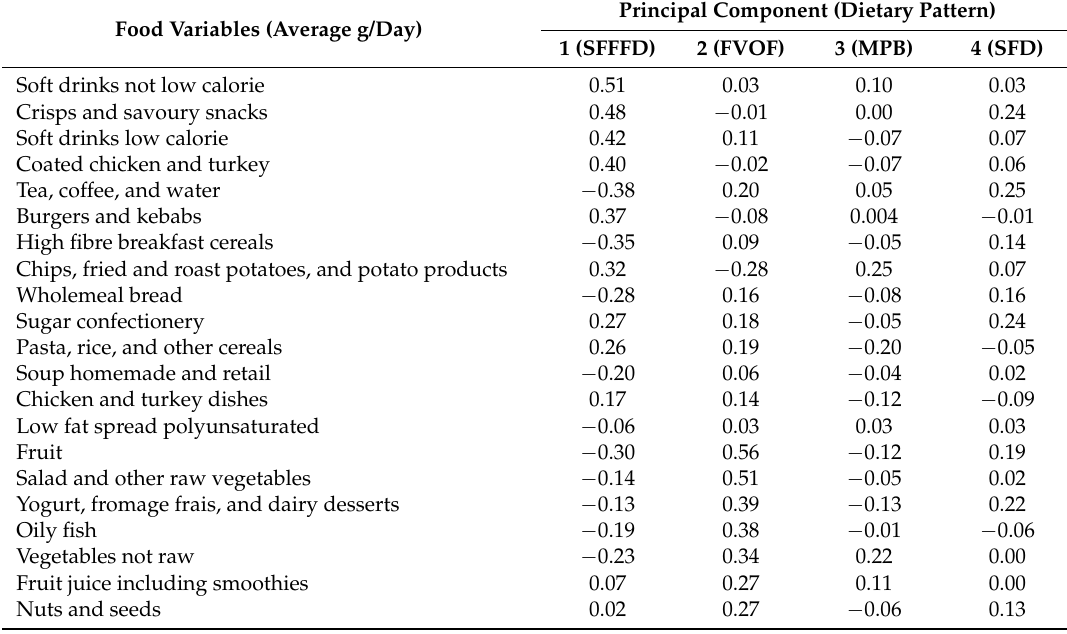
Table 3. Rotated PCA solution: food variables and factor loadings for each retained principal component (Dietary